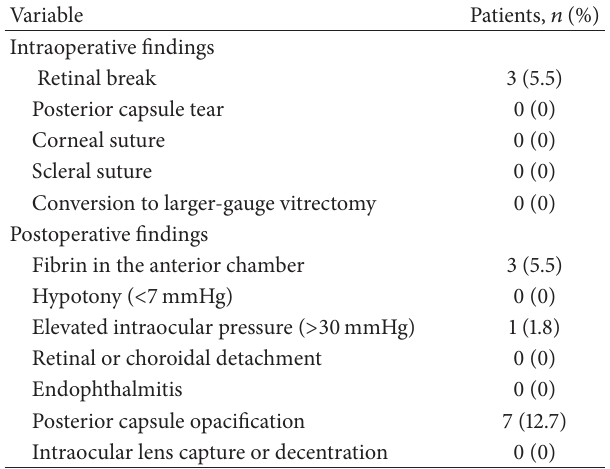
Table 3: Main outcomes: intraoperative and postoperative